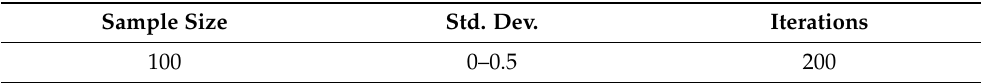
Table 2. Model parameters for the Example